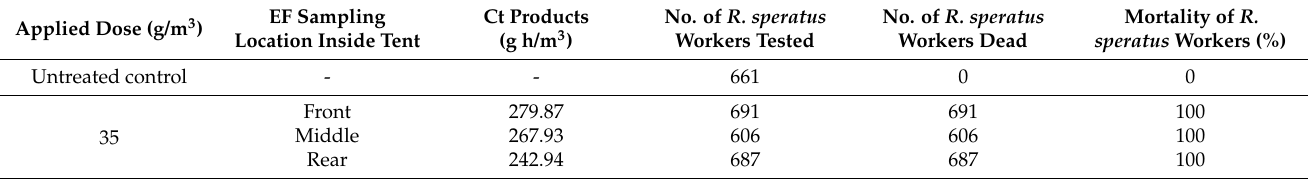
Table 3. Concentration × time (Ct) products (g h/m 3 ) of and the mortality of Reticulitermes speratus workers from 35 g/m 3 EF fumigation at 15 ± 1 ◦ C for 4 h treated on imported marble in commercial- scale fumigation trials conducted in a 33.6 m 3 tarpaulin